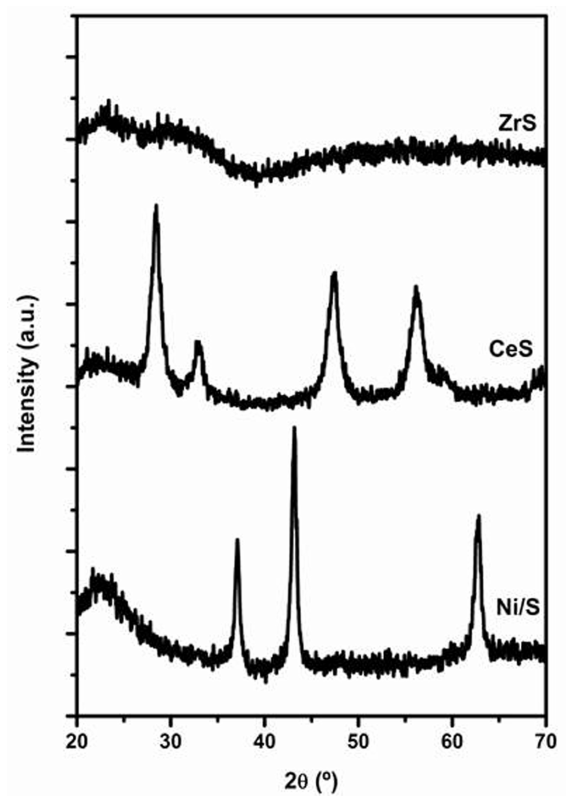
Figure 3. XRD patterns of the Ce- and Zr-modified silica